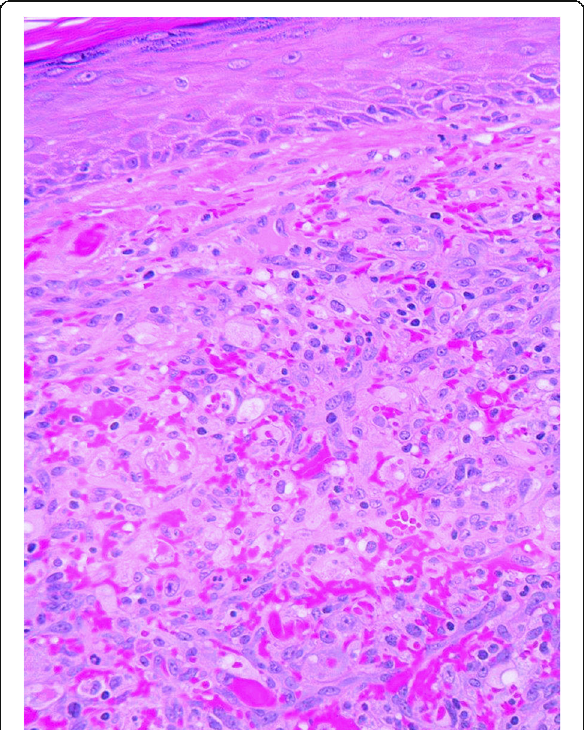
Fig. 2 Case 3 showing epithelioid cells exhibiting mild cytological atypia, large nuclei with easily discerned nucleoli, cytoplasmic vacuoles, occasional mitoses and an inflammatory infiltrate of lymphocytes, plasma cells and occasional